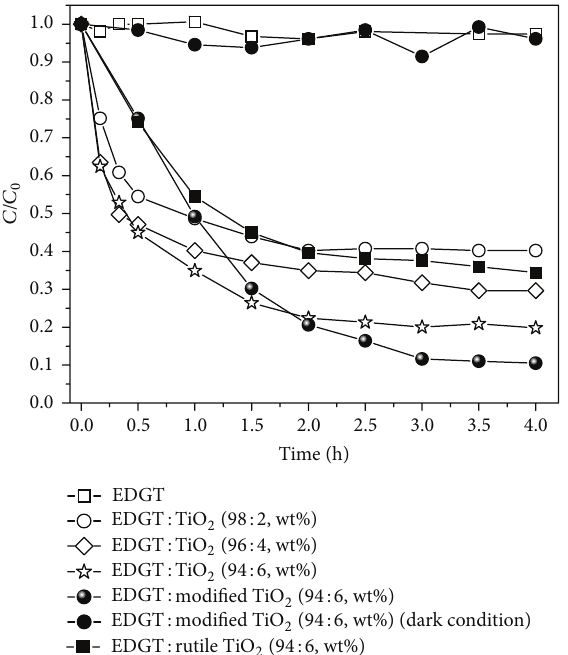
Figure 9: Comparison of absorbance peaks of residue of dyes under continuous light incidence in the presence of photocatalyst (anatase, rutile, and hybrid ZnO/TiO 2 in fibers) with control experiment.